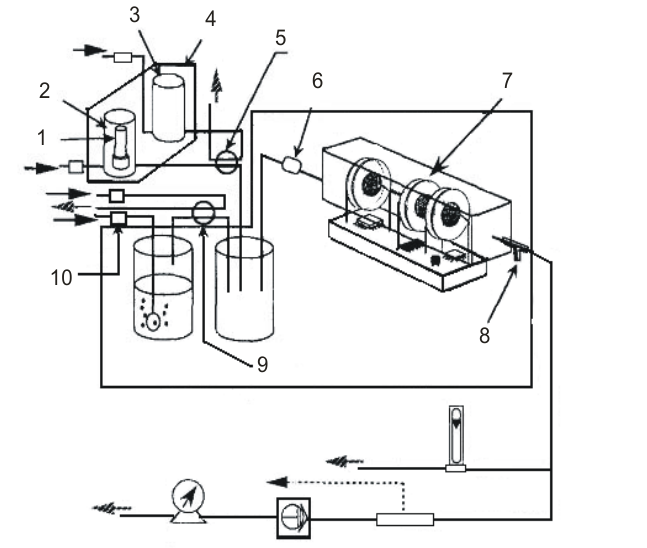
Figure 1. Circuit of gas-sorption experimental set:1,2 ampoule with compound; 3 intermediate buffer capacity; 4 thermostatic capacity; 5, 9 three-running crane; 6 buffer capacity; 7 cell of detecting; 8 two-running crane; 10 traps for impurity.